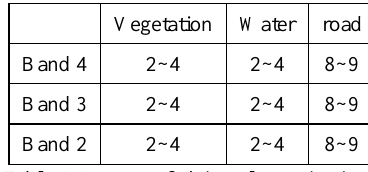
Figure 4. Semivariograms of the three object classes in site 1 in three different bands